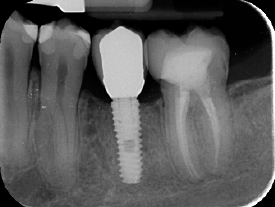
Figure 6. Radiographic view after prosthesis delivery.